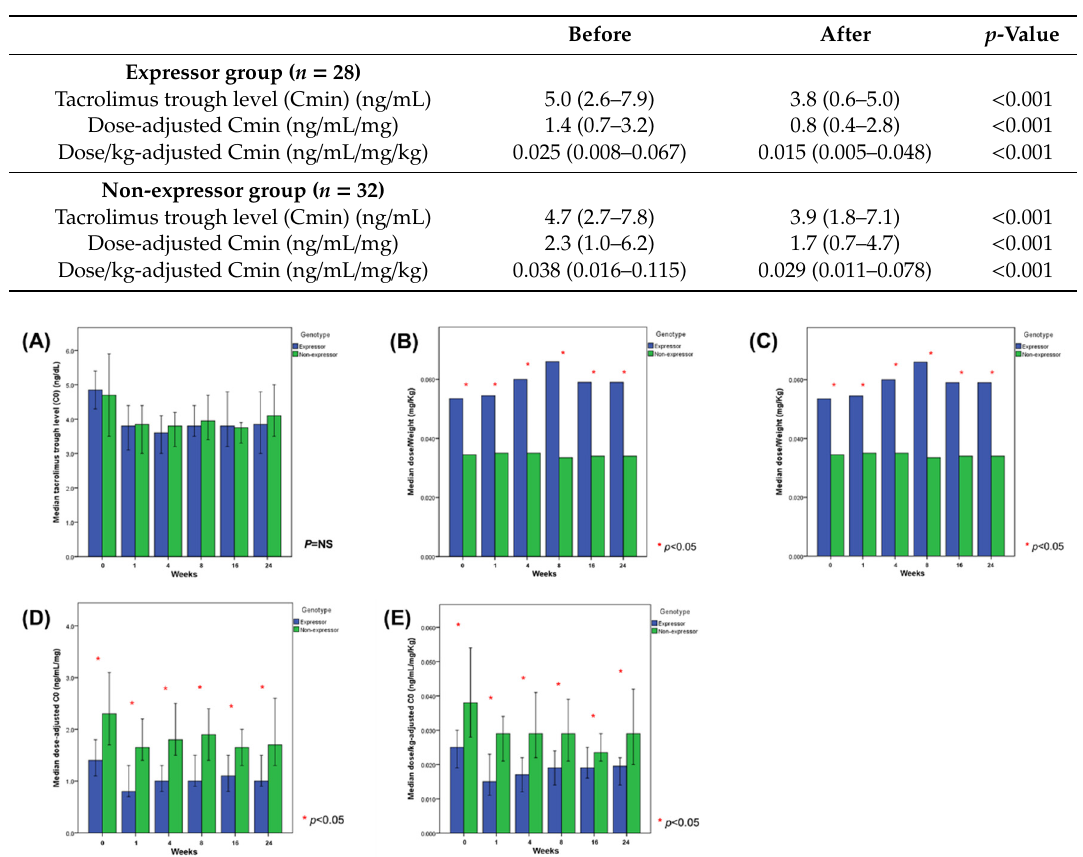
Table 2. Tacrolimus exposure parameters in CYP3A5 expressors and non-expressors before and after the conversion from twice-daily to once-daily extended-release formulation.